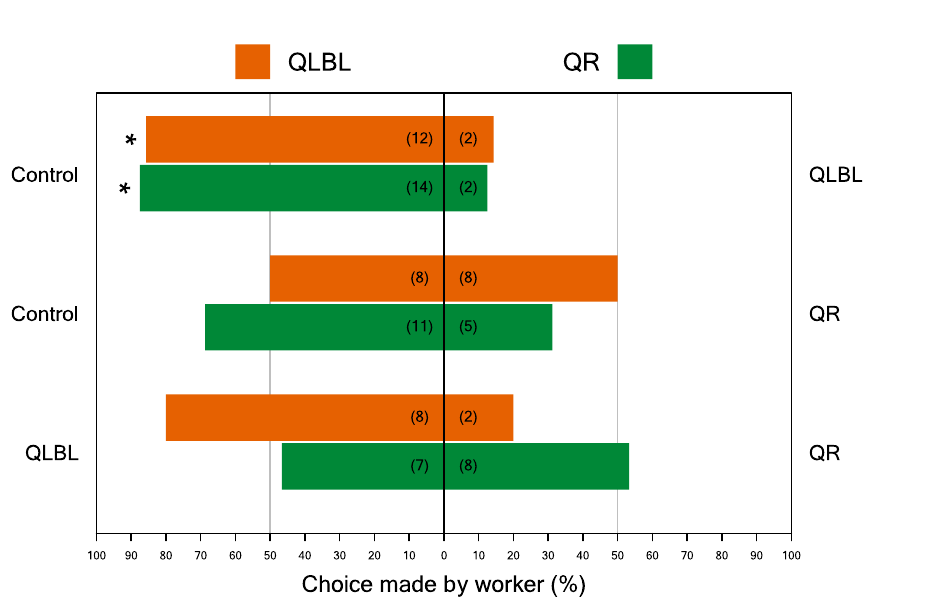
Figure 5. The proportion of queenless brood-less (QLBL) and queenright workers (QR) responding to 3 different combinations of stimuli, designated on the left and right of the plot: control vs. QLBL DG extract, control vs. QR DG extract, and QLBL vs. QR DG extract. Control stimuli consisted of callow worker DG extract. All stimuli were presented in the amount of 1 gland equivalent. The number of workers responding to each treatment is given in parenthesis on each bar. Orange bars represent QLBL response bees, and green bars represent QR response bees. Asterisks indicate significance (p < 0.05) using exact binomial